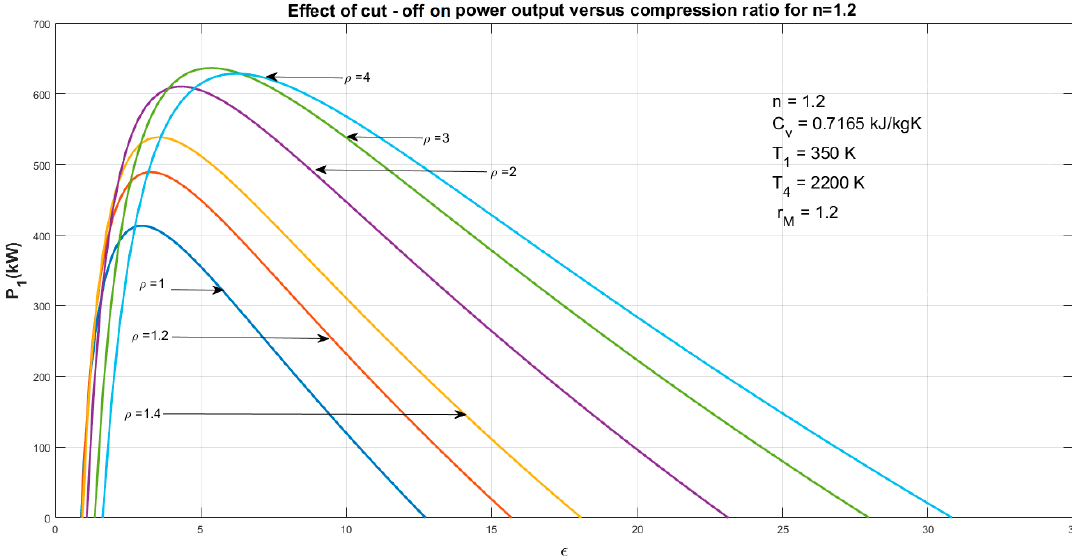
Figure 3. Effect of ρ on P 1 versus ε ( n = 1.2). Figure 3. E ff ect of ρ on P 1 versus ε ( n =